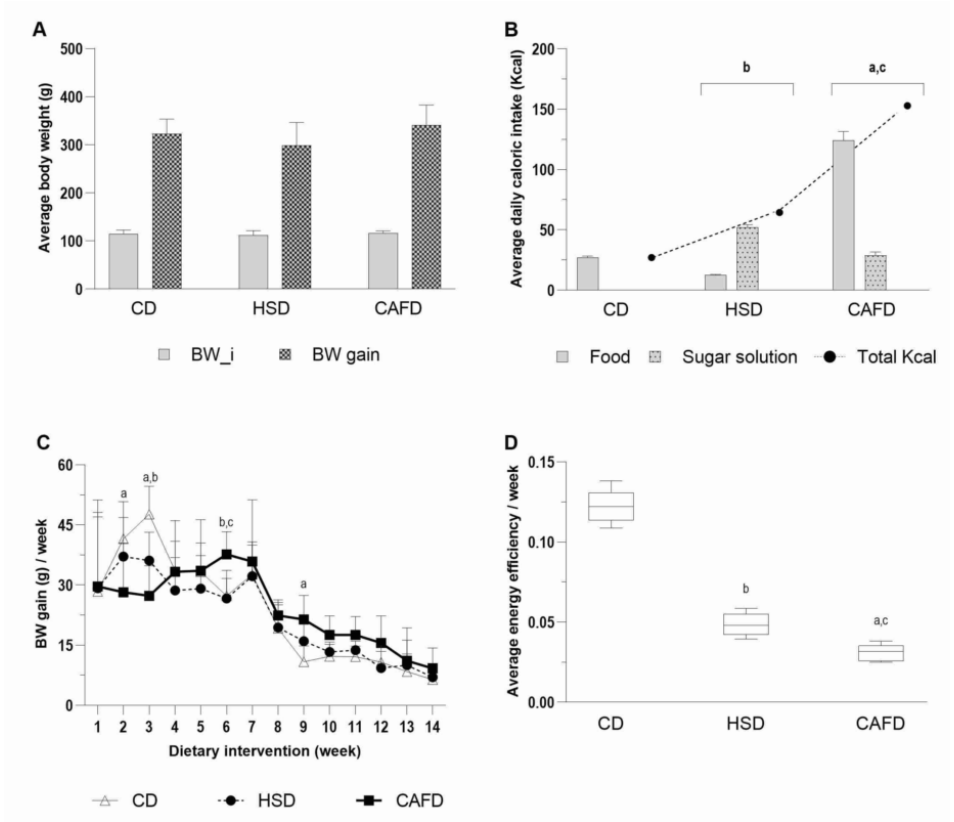
Figure 1. Graphical representation of the effects of the diets on energy intake and body composition parameters. ( A ) Body weight (g) at the beginning (BW_i) and weight gain after 14 weeks of diet intervention. ( B ) Total daily energy (Kcal) and caloric intake in food and sugar solution diets. ( C ) Body weight variation across the entire dietary experiment. ( D ) Average energy efficiency per week. BW, body weight; CD, chow diet; CAFD, cafeteria diet; HSD, high-sugar diet. Values represent mean ± SD ( n = 9). Common letters indicate statistically significant differences between the associated groups: a CD vs. CAFD; b CD vs. HSD; c HSD vs. CAFD. The Lee obesity index was comparable among groups fed with chow, HSD and CAFD both at the beginning (306 ± 11, 307 ± 14 and 310 ± 20, respectively) and at the end of the study (304 ± 13, 296 ± 20 and 314 ± 24, respectively). The upper and lower limits of the 95% confidence intervals (CI) for the Lee obesity index showed higher variations in